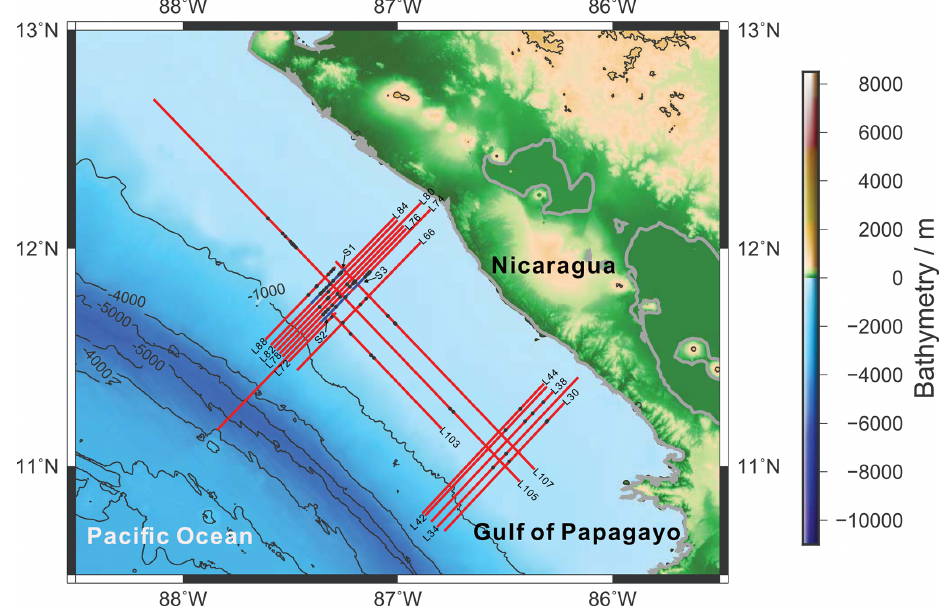
Figure 1. Distribution of multichannel seismic data. The red lines indicate the positions of the survey lines, and the black filled circles on the red lines indicate the positions of the observed mode-2 ISWs. The blue lines S1, S2, and S3 are part of the seismic sections containing the mode-2 ISWs, which will be displayed in Figs. 3 and